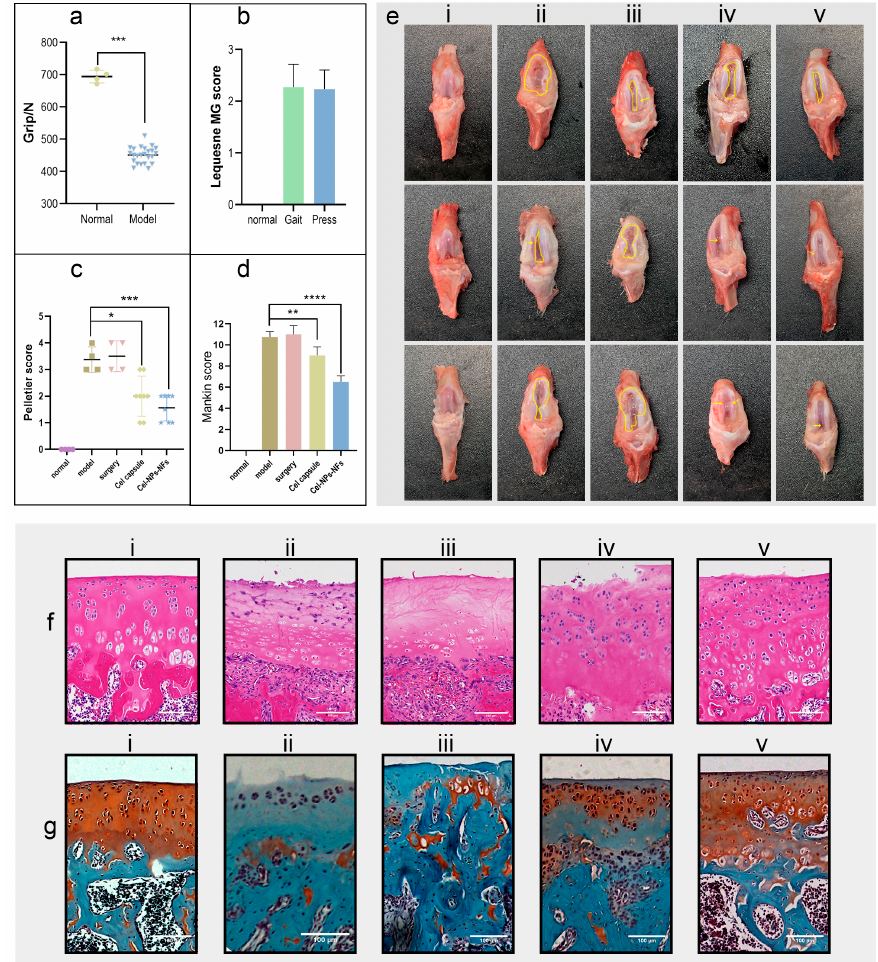
Figure 7. Study of the drug delivery performance in the OA rat model; ( a ) Analysis of hind limb grip of rats before administrating one-way ANOVA between the normally fed and model groups ( p < 0.001); ( b ) The behavioral Lequesne MG score of OA model rats (including gait and knee joint compressions); 0 indicates the slightest degree without pathological changes, and 4 indicates the most severe pathological changes; ( c ) After treatment, the gross Pelletier score of the knee joint (corresponding to ( e )), 0 was the slightest without lesion, 5 was the most serious, with Dunnett multiple comparisons (* means p < 0.05, *** means p < 0.001); ( d ) Combined with the HE section and saffron fast green staining section ((corresponding to ( f , g )), according to the degree of pathological changes of Mankin score. A 0 score was the lightest without pathological changes, with 15 indicating that the lesion was the most serious, with the Dunnett multiple comparisons (** means p < 0.01, **** means p < 0.0001); ( e ) Gross view of cartilage (i, the normal group; ii, the model group; iii, the model sham operation group; iv, positive control group; v, the Cel-NPs-NFs treatment group); ( f ) HE section (scale: 100 μ m); ( g ) Fuchsin fast green staining section (scale: 100 μ m).